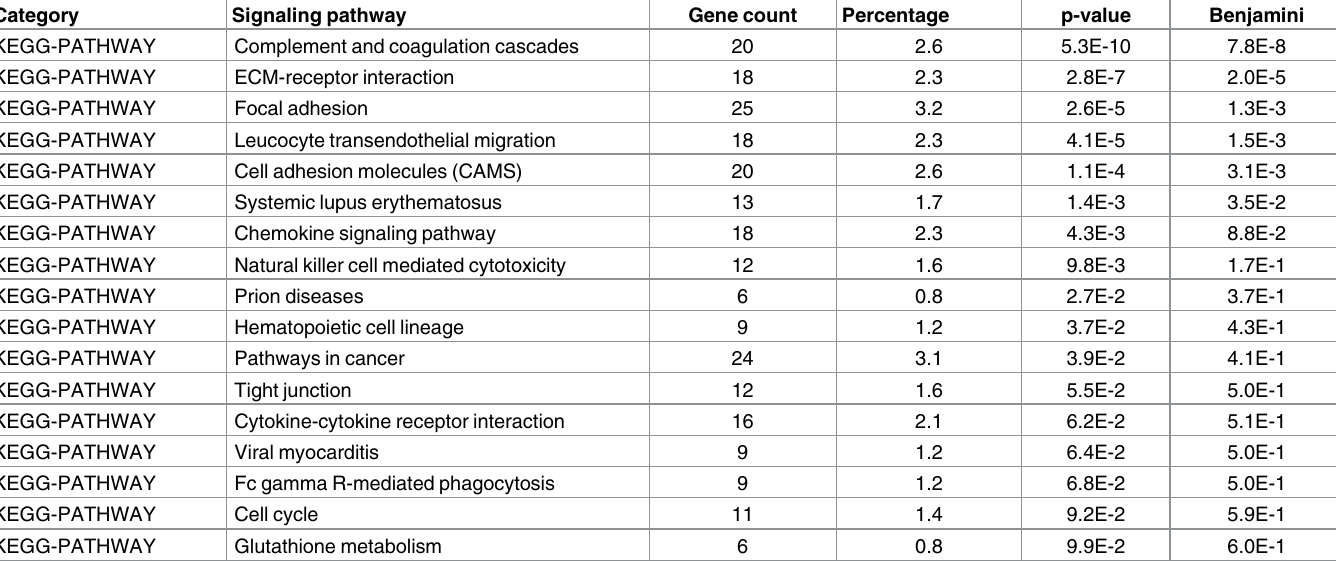
The gene heading indicates number of genes mapped to an ontology category. P-values derived from Fisher’s exact test and Benjamini multiple test correlation. Gene ontology (GO) analysis and pathway analysis of genes also done using DAVID (Database for Annotation, Visualization of Integrated Discovery) enrichment analysis tool from National Institute of Allergy and Infectious diseases (NIAID),